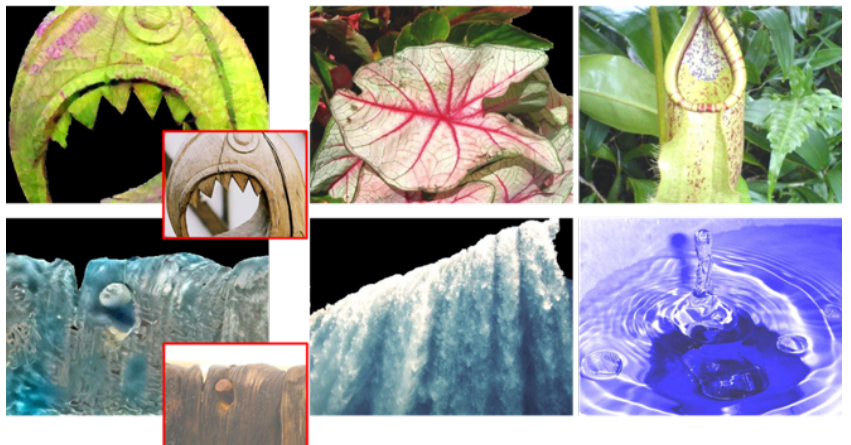
Figure 14. Examples of synthesized images with more votes (i.e., perceived as fake). Each row shows the image triplets shown in one question (1st row: foliage; 2nd row: water). The most-voted pictures are shown from ( left ) to ( right ). The synthesized results of foliage and water got 88% and 85% votes of the votes, respectively (content image in